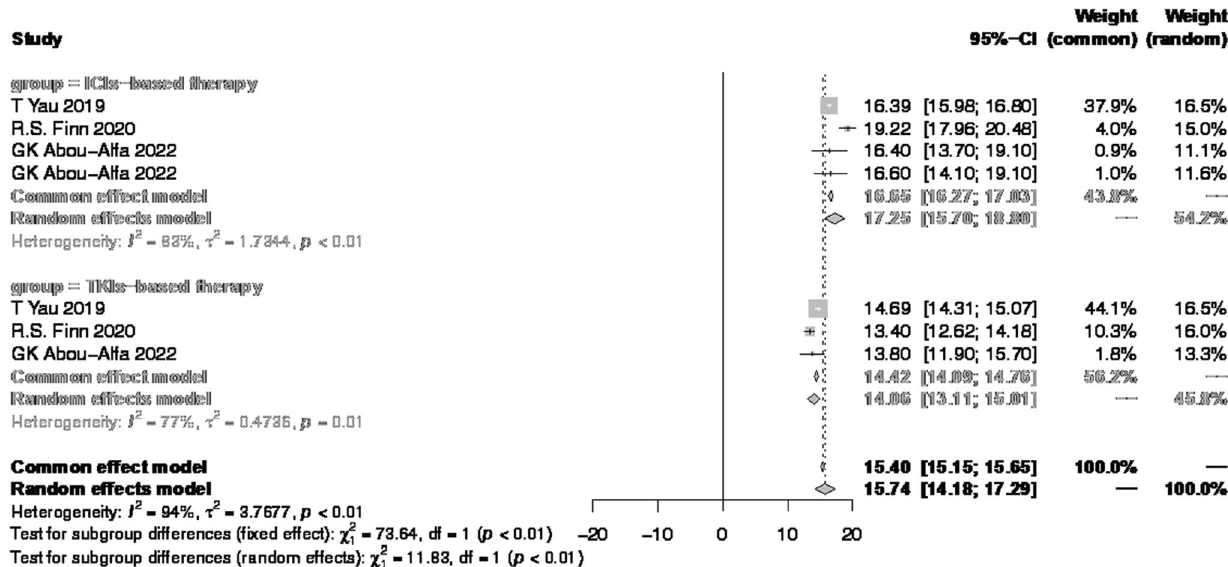
Fig. 6 Pooled results of OS of ICIs vs